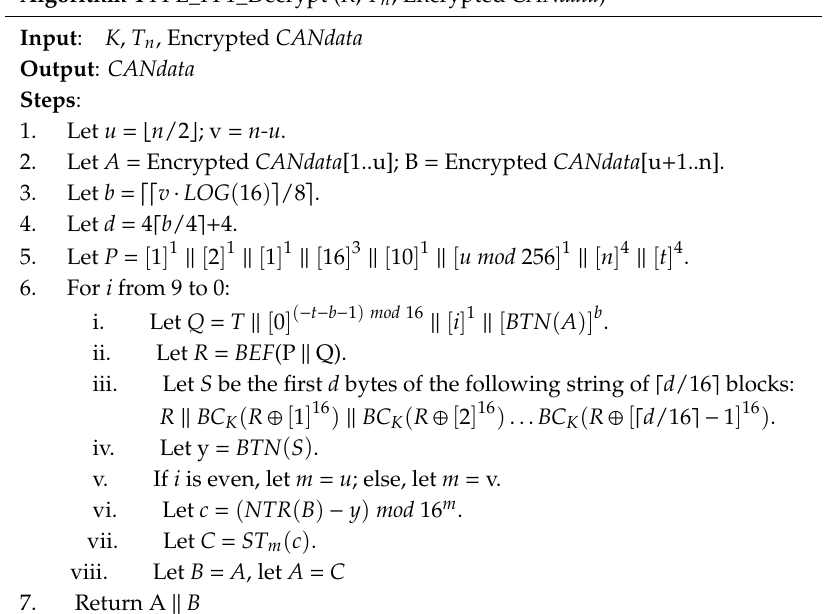
Algorithm 4 FPE_FF1_Decrypt ( K , T n , Encrypted CANdata